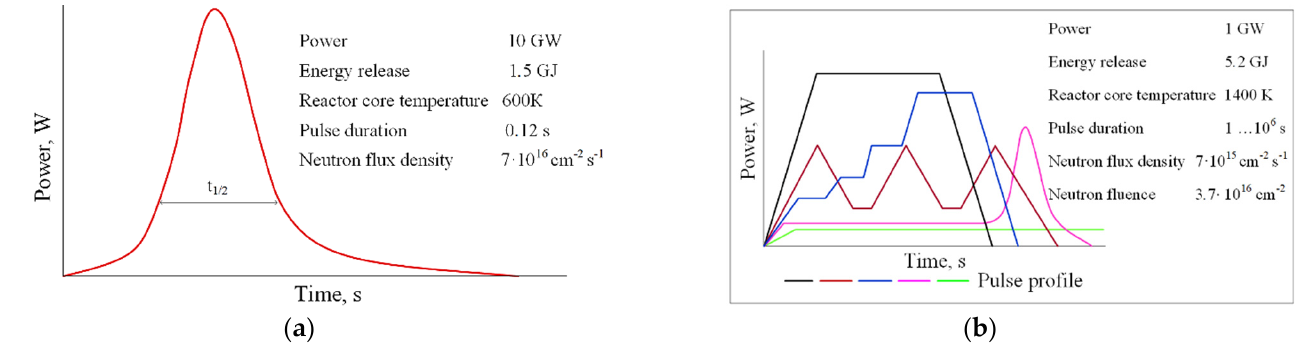
Figure 1. IGR Reactor Operation Modes: ( а ) mode “Burst”; ( b ) “Pulse”. To carry out self-quenching mode of neutron burst (mode “Burst”), the reactor is given some positive reactivity that determines the shape, amplitude, and half-width of burst; burst quenching is due to the negative temperature effect of the reactivity.